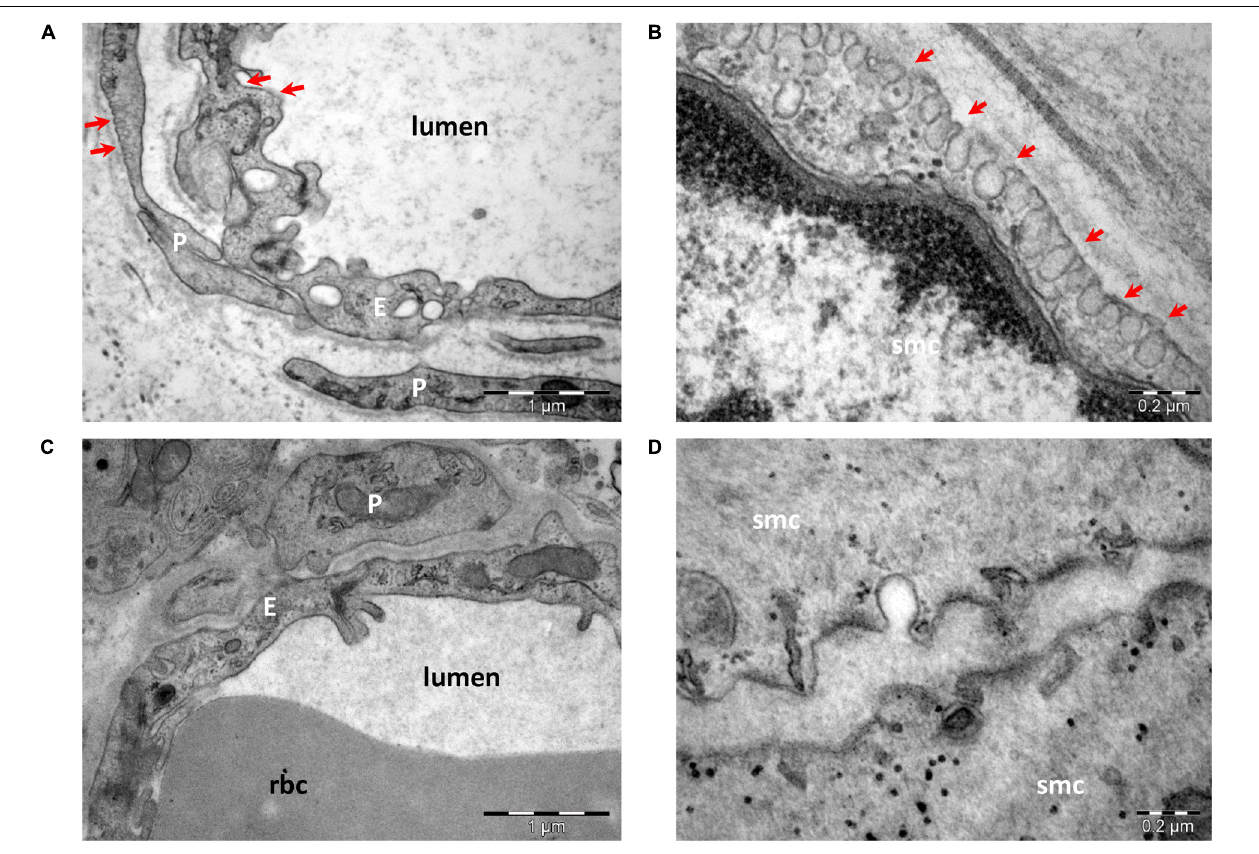
FIGURE 2 | Transmission electron microscopy of endothelial cells (A,C) and smooth muscle cells (B,D) from wild-type (A,B) and Cav-1 KO (C,D) mice. Caveolae (arrows) are present in endothelial cells (E), pericytes (P), and smooth muscle cells (smc) in wild type (A,B) . Note the lack of caveolae in cells from Cav-1 KO mice (C,D) (image collection, Department of Ultrastructural Pathology, “Victor Babes” Institute of Pathology,